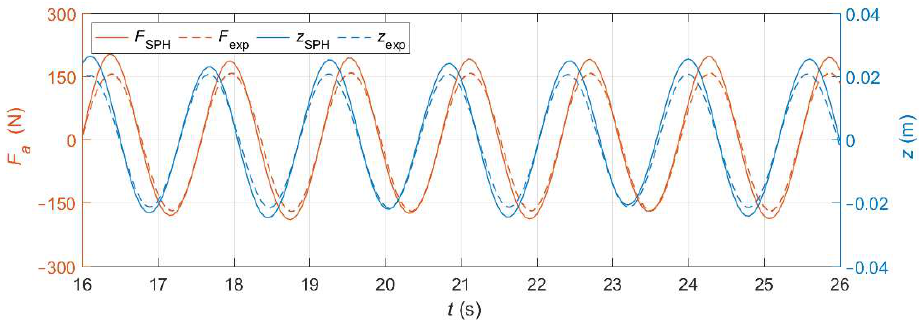
Figure 16. Numerical and experimental time series of the actuator force (left axis) and heave position (right axis) with a closed-loop system.